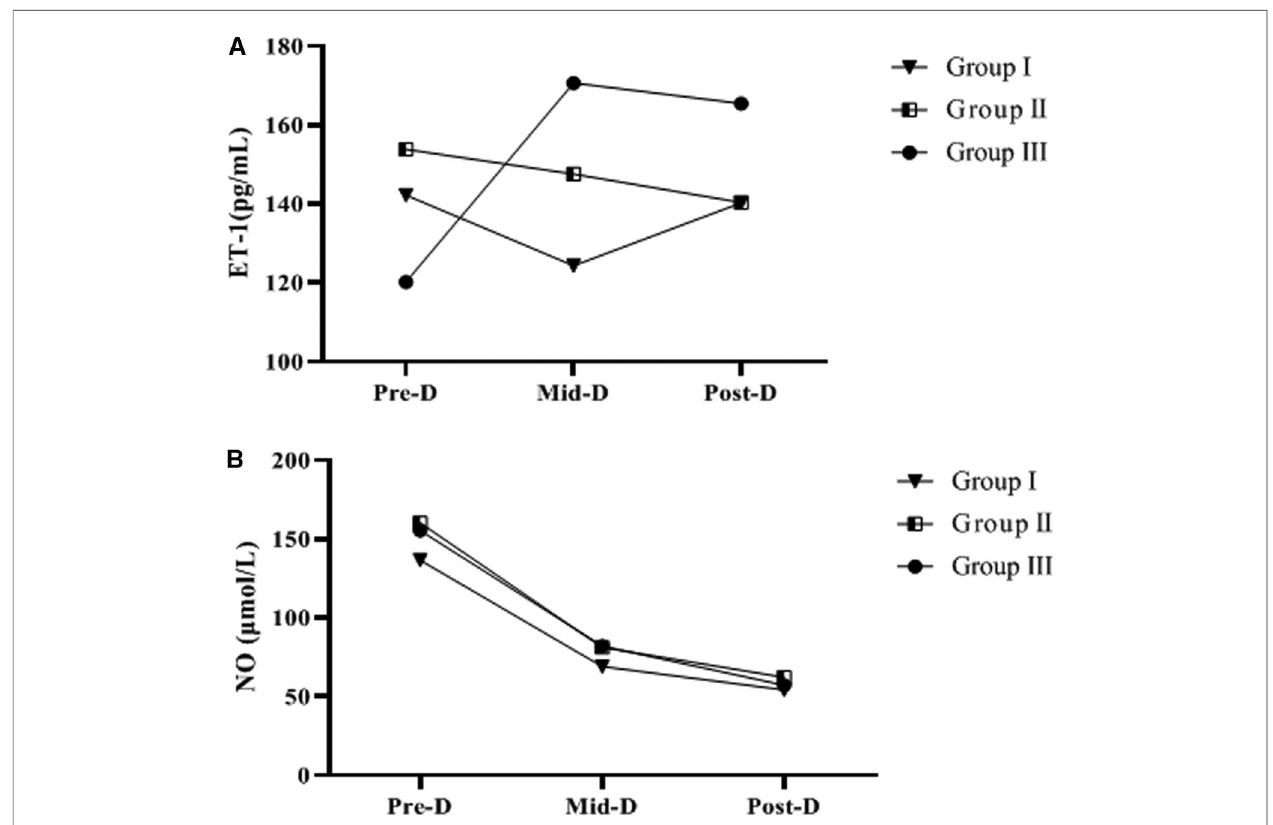
FIGURE 2 | Trends of ET-1, NO levels in the three groups. A indicates the trend in ET-1 levels. B is the change trend of NO level.